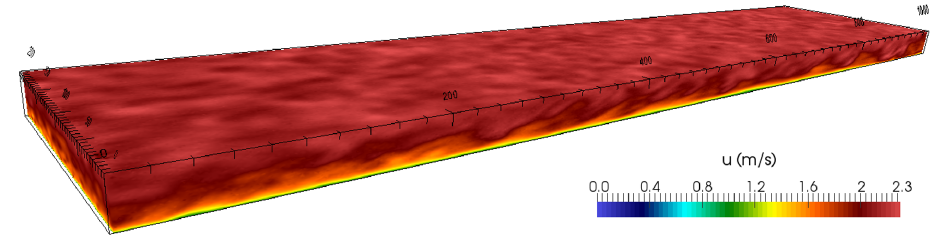
Figure 3. Velocity magnitude distribution of the empty channel at t = 1800